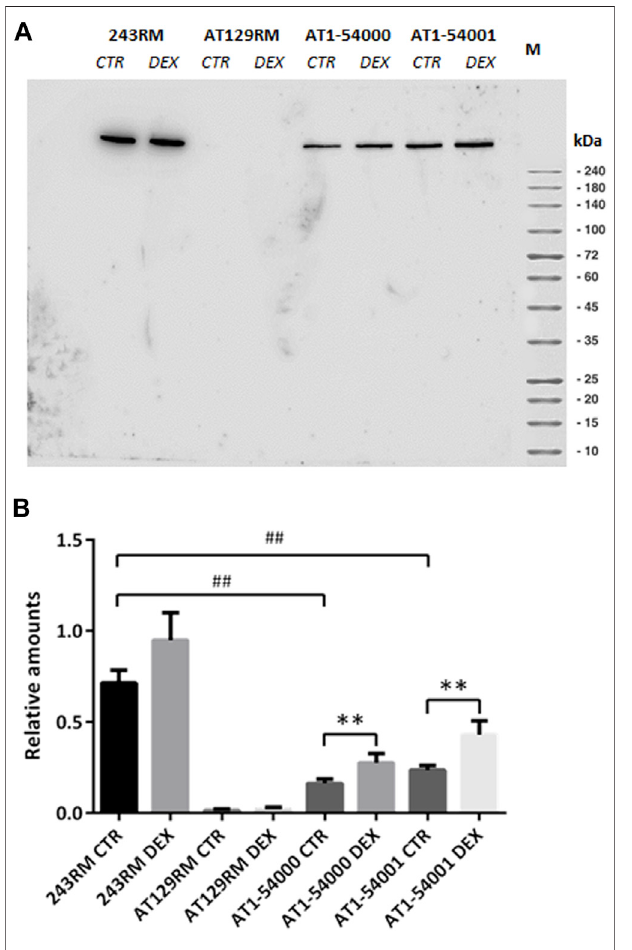
FIGURE 3 | Protein quanti fi cation in LCL extracts. (A) Western blot analysis of ATM protein in WT (243RM), classical AT (AT129RM), AT1-54000 and AT1-54001 cells treated with 100 nM DEX for 24 h or not treated. (B) Quanti fi cation of the relative amounts of ATM protein in the total cell extracts of WT and AT cells shown in A. Blots shown are representative and thevaluesarethemeansandSEMoffourindependentexperiments.Statistics has been performed by comparing the WT CTR sample with the mutant CTR samples (Mann-Whitney test, ## two-tailed p values < 0.005) or by comparing the same LCL without or with DEX treatment (Wilcoxon signed rand test; **two-tailed p -values < 0.005).